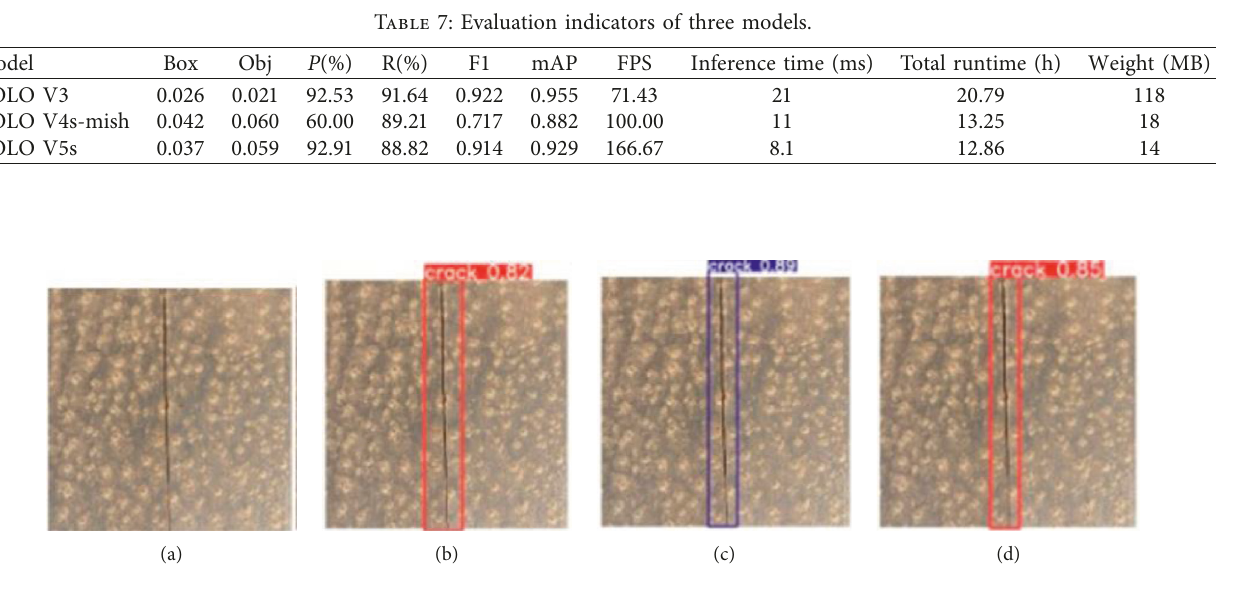
Figure 8: Model test effect pictures, (a) Test chart, (b) YOLO v3, (c) YOLO v4s-mish, and (d) YOLO